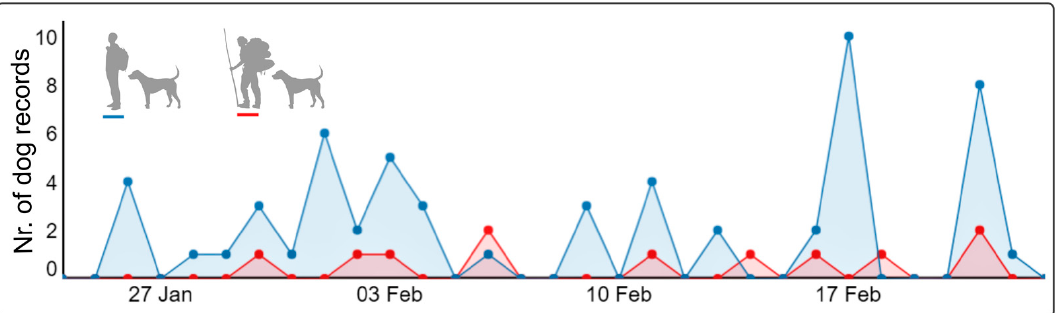
Figure 3. Number of dog records of dogs accompanying hikers with small (blue line) and large (red line) backpacks along three trekking trails in southern Chile ( n = 56). Data from three camera-traps during an exposure period of four weeks (01/25/2019–02/22/2019). Illustrations downloaded from Pixabay.com.